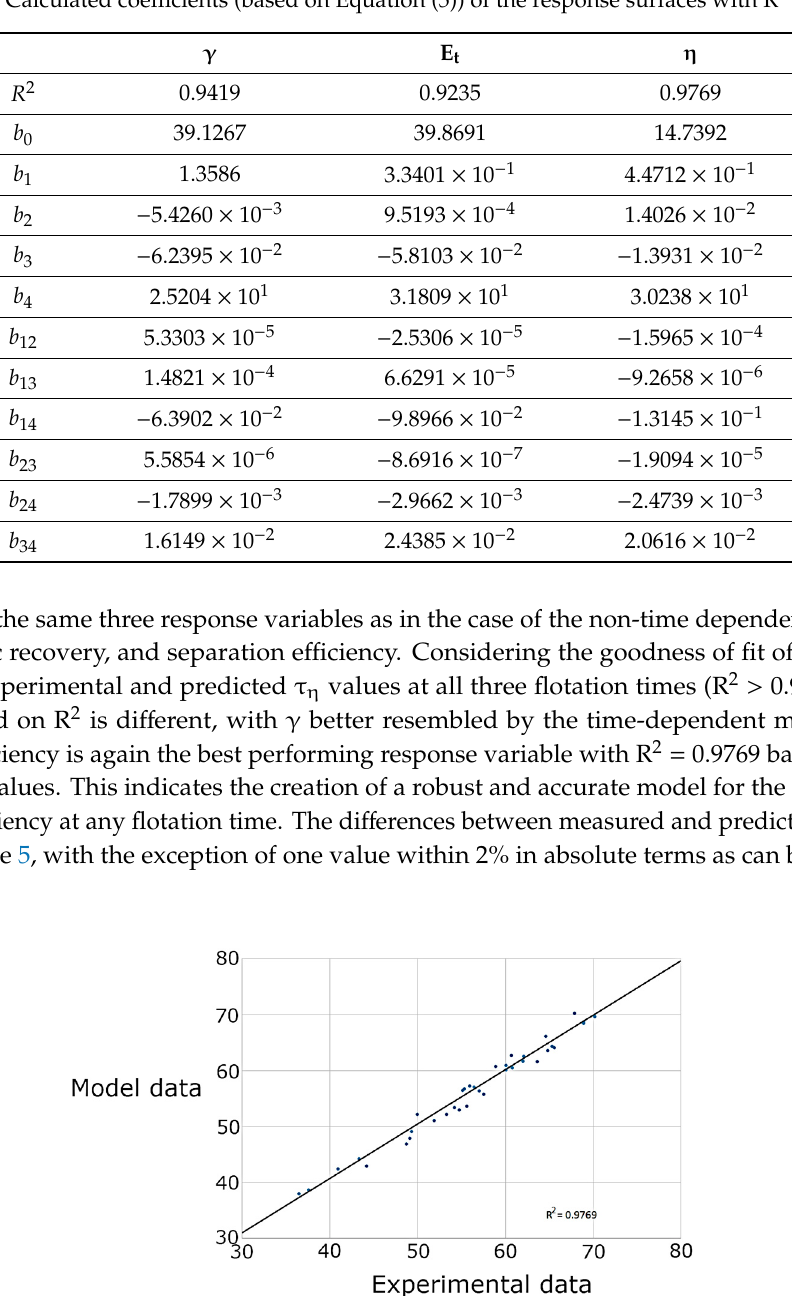
Table 7. Calculated coe ffi cients (based on Equation (5)) of the response surfaces with R 2 > 0.9.